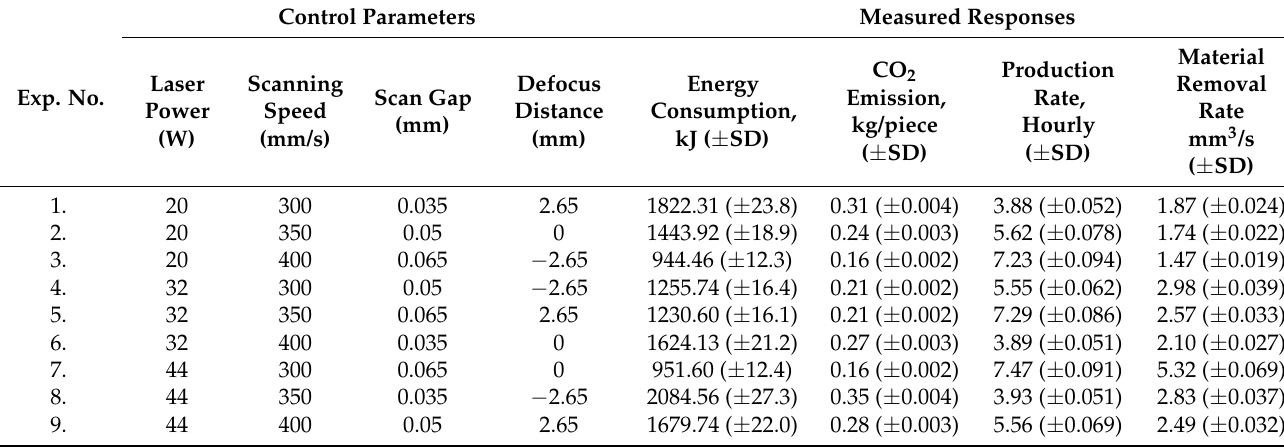
Table 2. Design matrix with input factors and measured